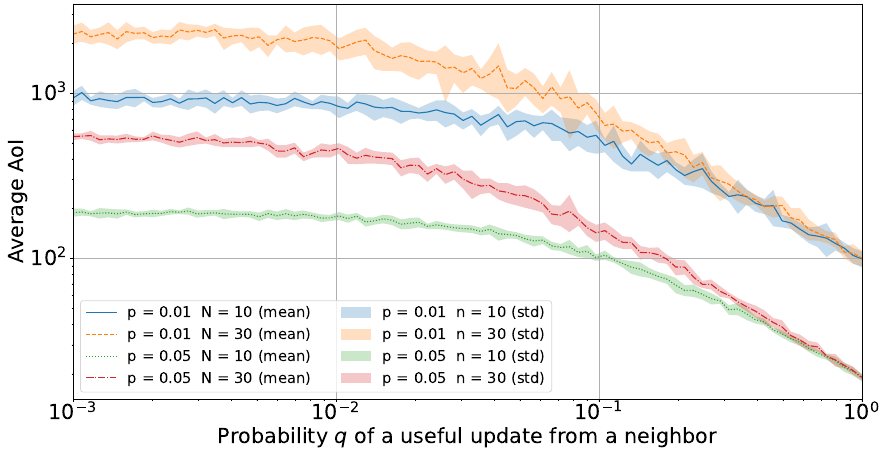
Figure 7. Average AoI with a variable probability q during the simulation of the time-division multiple access for various values of p and N